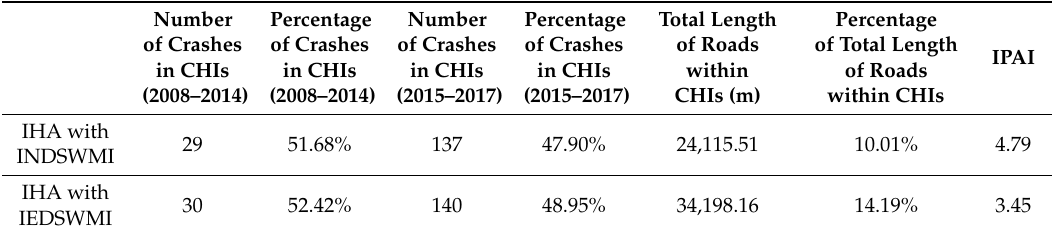
Table 6. The IPAI and the percentage of CHIs